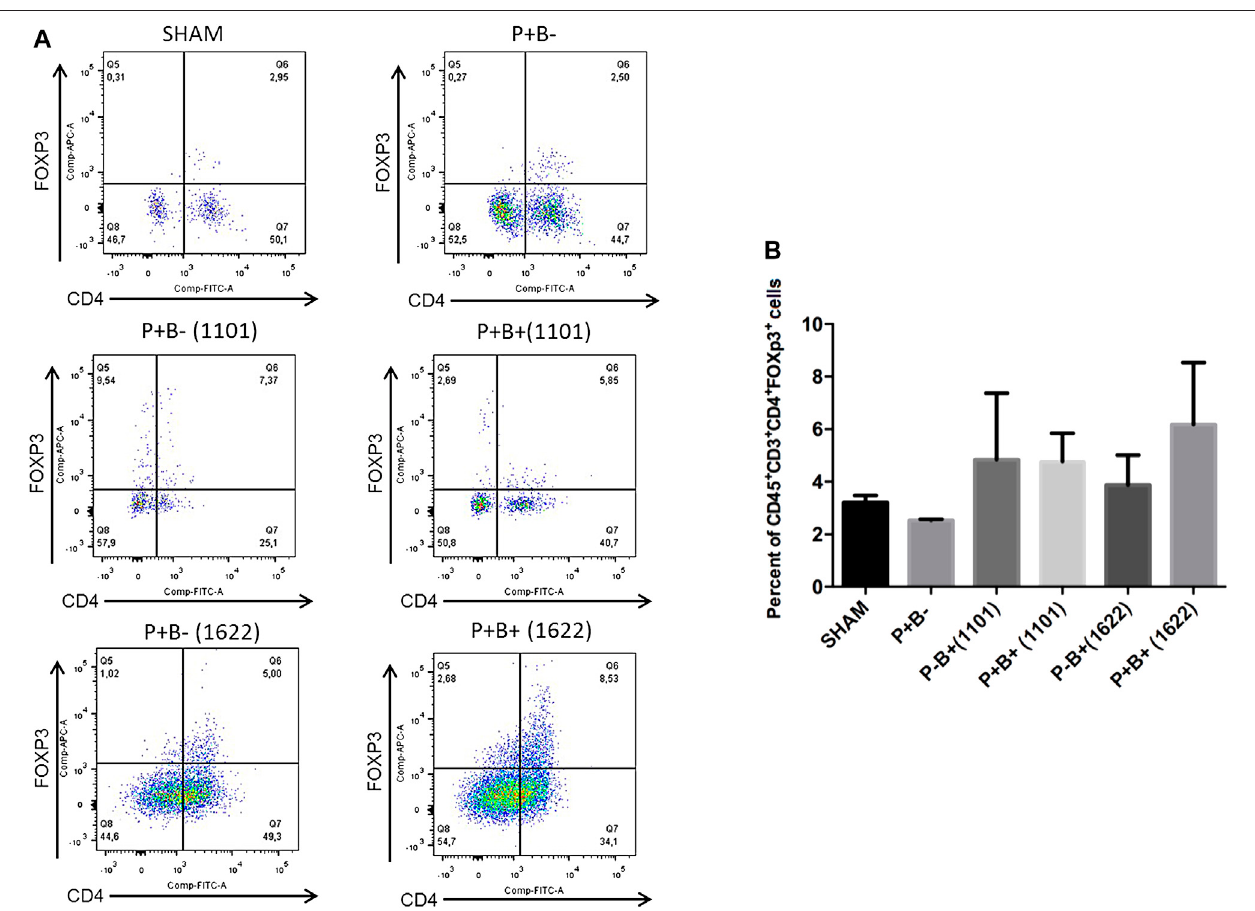
FIGURE4| TregpopulationsremainedunchangedingingivaltissuesofC57Bl/6micesubmittedtodifferenttreatments:SHAM(negativecontrol),P+B-(microbial consortium), P-B+ (1101) ( B. breve 110 1A ), P + B+ (1101) (microbial consortium + B. breve 110 1A ), P-B+ (1622) ( B. bi fi dum 162 2A ) and P + B+ (1622) (microbial consortium + B. bi fi dum 162 2A ). In (A) representative fl ow cytometry diagram showing the gating of CD4 + , FoxP3+ Treg cells. In (B) Average percentages of CD4 + , FoxP3+Tregcells.Nodifferencesamongthegroups.ANOVA, Tukey ’ smultiplecomparison, p > 0.05%.Facsplotsrepresent theresults ofoneoftwoindependent experiments with similar results ( n (cid:1) 2 pooled samples from 4 mice/per